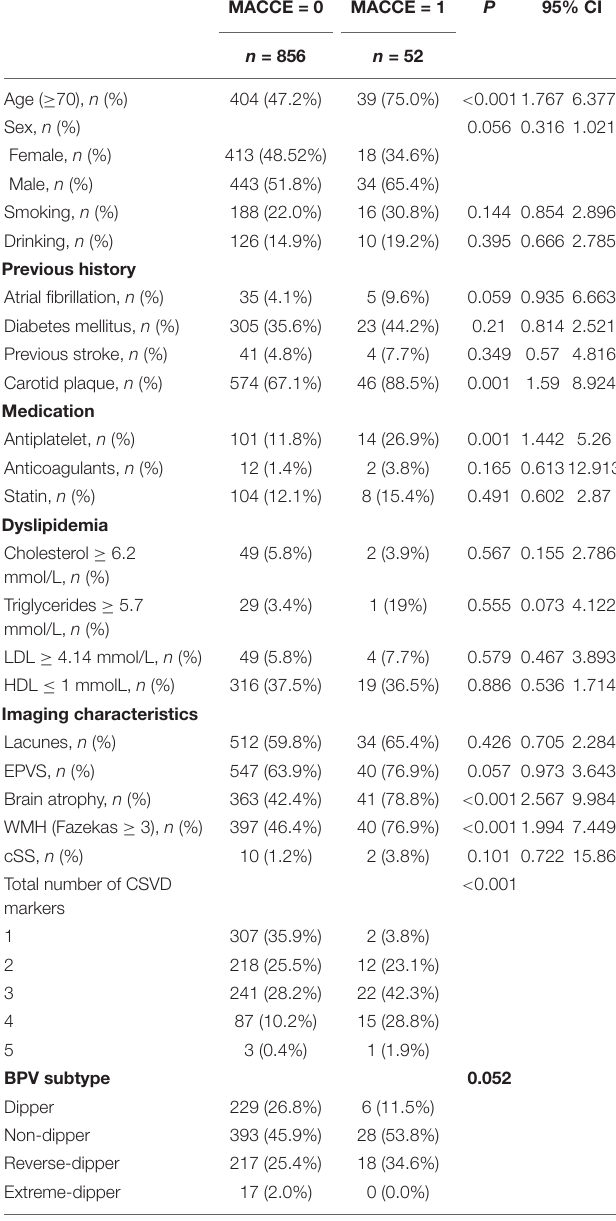
TABLE 1 | Demographics and clinical